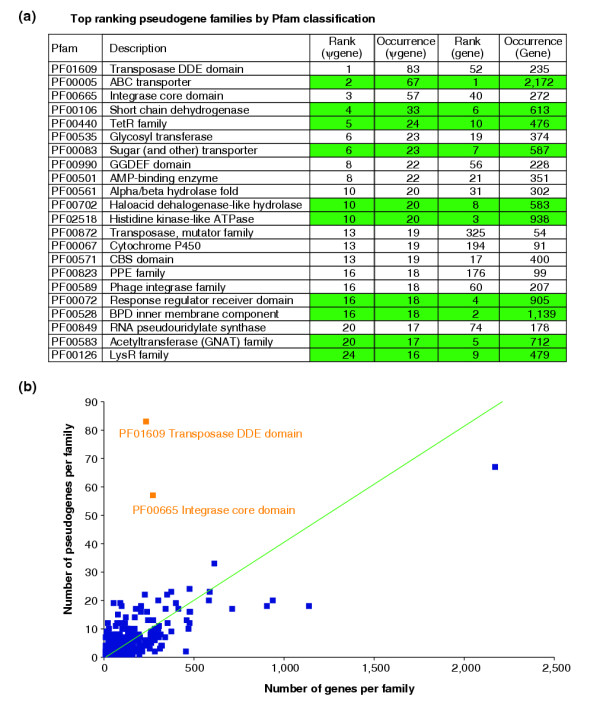
Gene-to-pseudogene ratios. (a) The top 20 pseudogene families and top 10 gene families based on Pfam classification. Ranking is based on the size of pseudogene families. The top 10 gene families are highlighted with the green background. (b) The number of genes plotted against the number of pseudogenes in a Pfam family. The line represents the overall ratio of the number of pseudogenes to the number of genes in the 64 genomes.